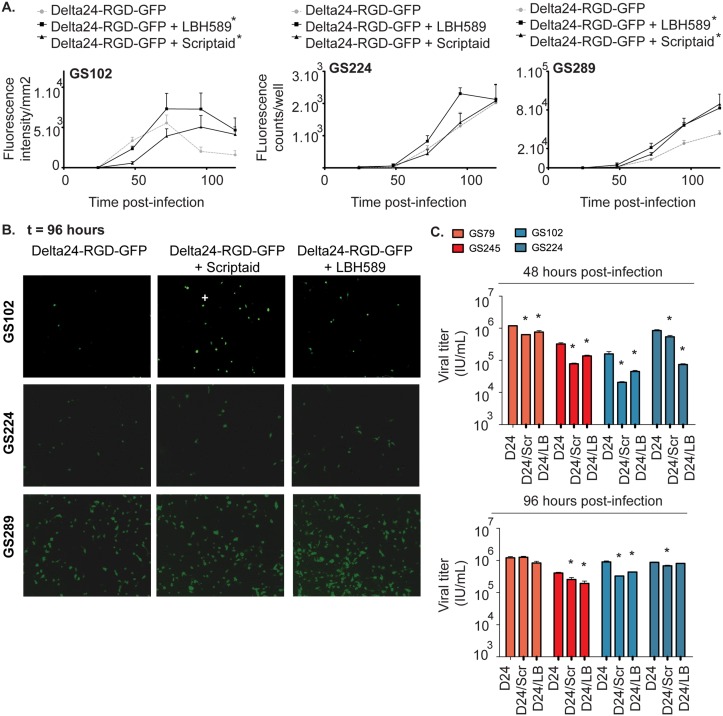
The effects of HDACi on viral transgene expression, replication and production.(A) GS 102, GS224 and GS289 cells were concomitantly treated with LBH589 or Scriptaid and Delta24-RGD-GFP virus. In a time-lapse, fluorescence intensity per mm2 and counts per well were measured and analyzed using the IncuCyte system and Image J, respectively. The results were plotted graphically as means ± standard deviation. *Indicates significance of the combination treatments compared to Delta24-RGD alone (p<0.05). (B) Representative fluorescence images acquired by the IncuCyte system at 96 hours are shown of GS102, GS224 and GS289 (magnification 10X). (C) Cells of the responsive GSCs GS102 and GS224 (blue), and cells of the non-responsive GSC cultures GS79 and GS245 (red) were concomitantly treated with Delta24-RGD and LBH589 or Scriptaid. The viral titers in the cell extracts that were obtained at 48h and 96h post-treatment are shown. *Indicates significant difference in the viral titers of Delta24-RGD alone compared to the combination treatments with HDACi and Delta24-RGD (p<0.05).